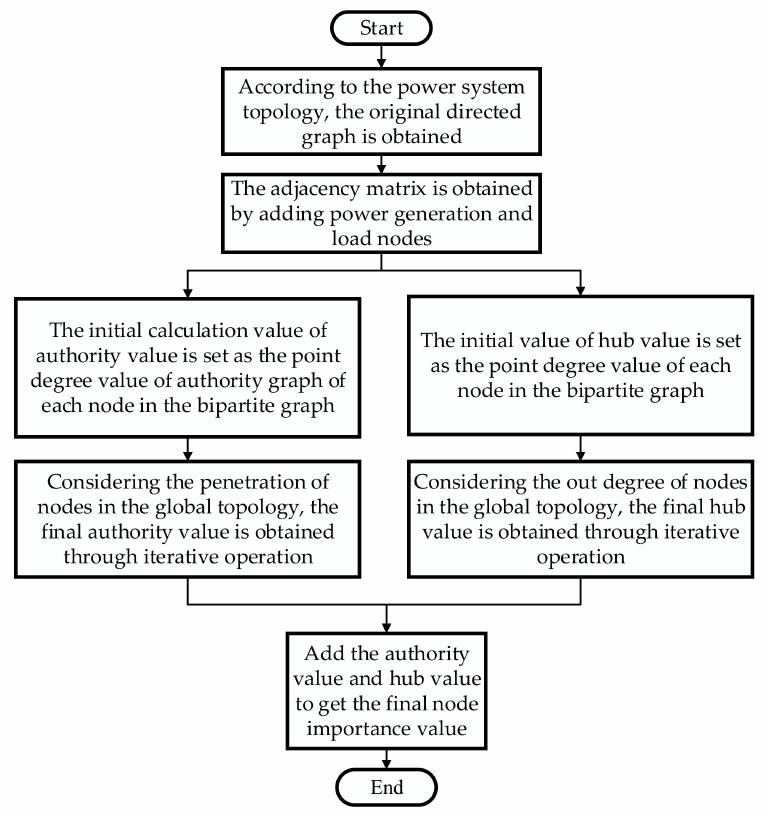
Figure 3. EB-SALSA algorithm flow